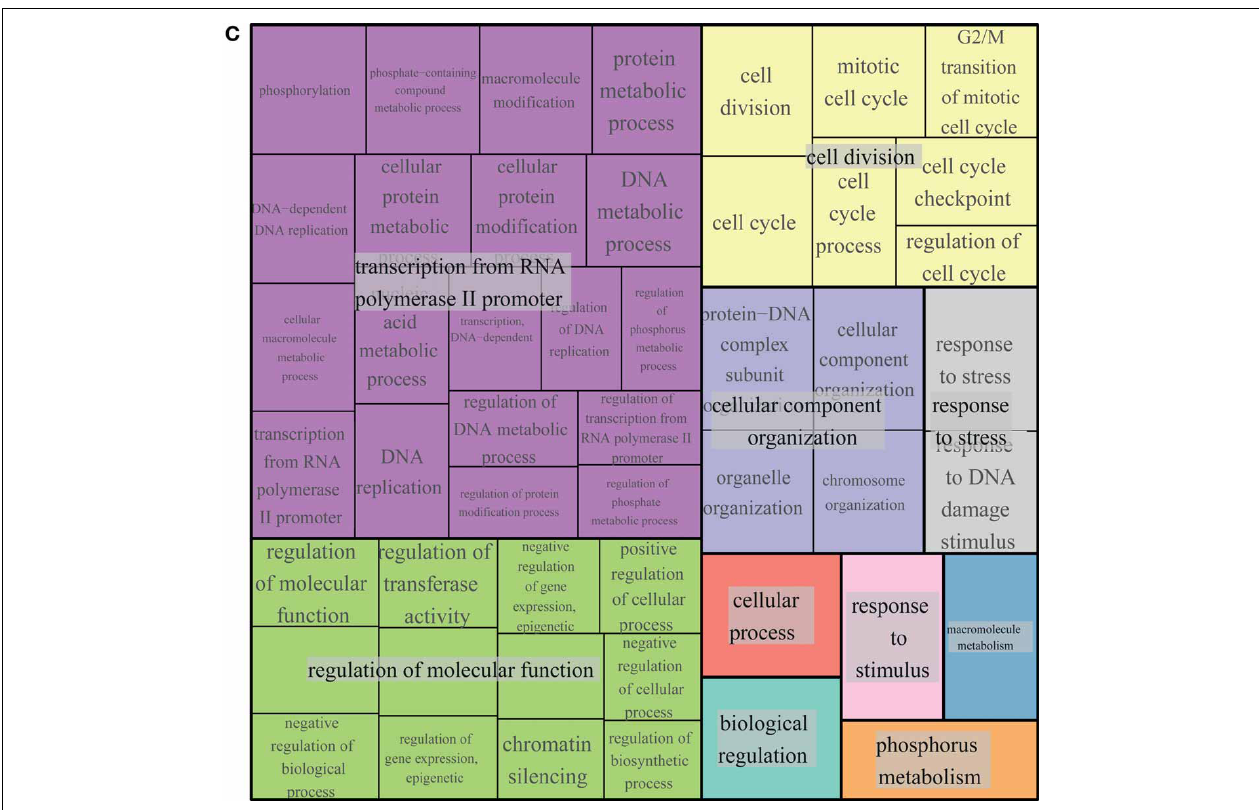
FIGURE 7 | GO term enrichment of Whi5, Rb and common interactors. Treemap of GO term enrichment of Whi5 (A) , Rb (B) and common (C) interactors generated by the web service Revigo based on p -value of GO term enrichment of Biological Process.